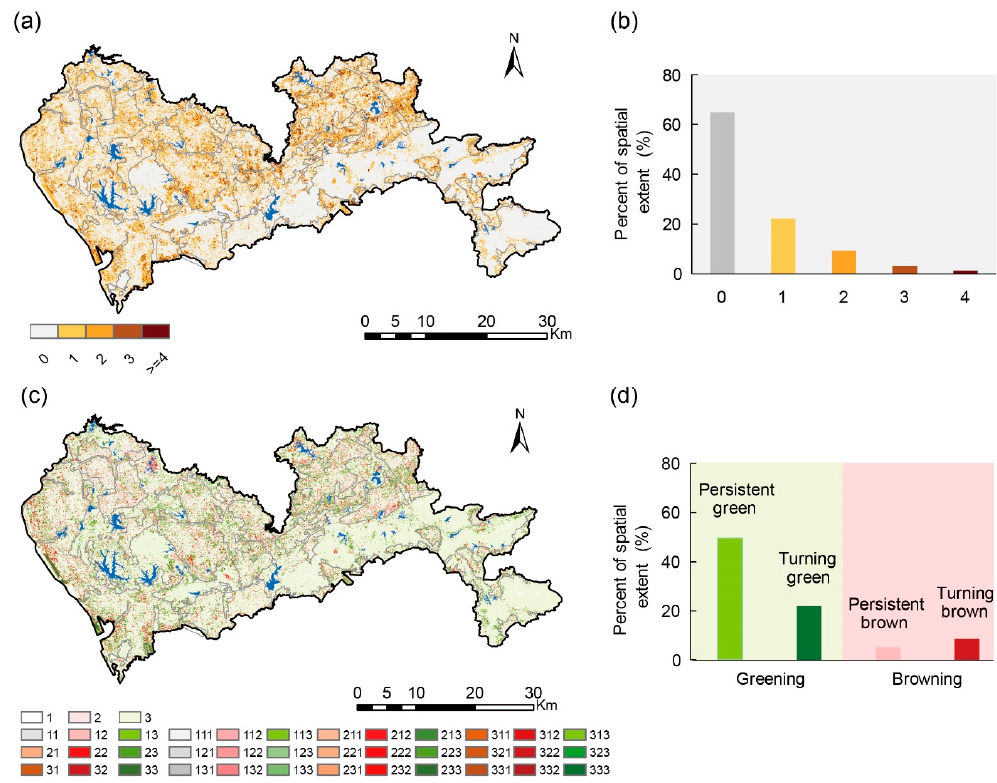
Figure 4. Spatial pattern of the change incident and process of vegetation change: ( a ) number of change frequency, ( b ) percent of each level on change frequency, ( c ) process of vegetation greenness, and ( d ) percent of greening and browning.